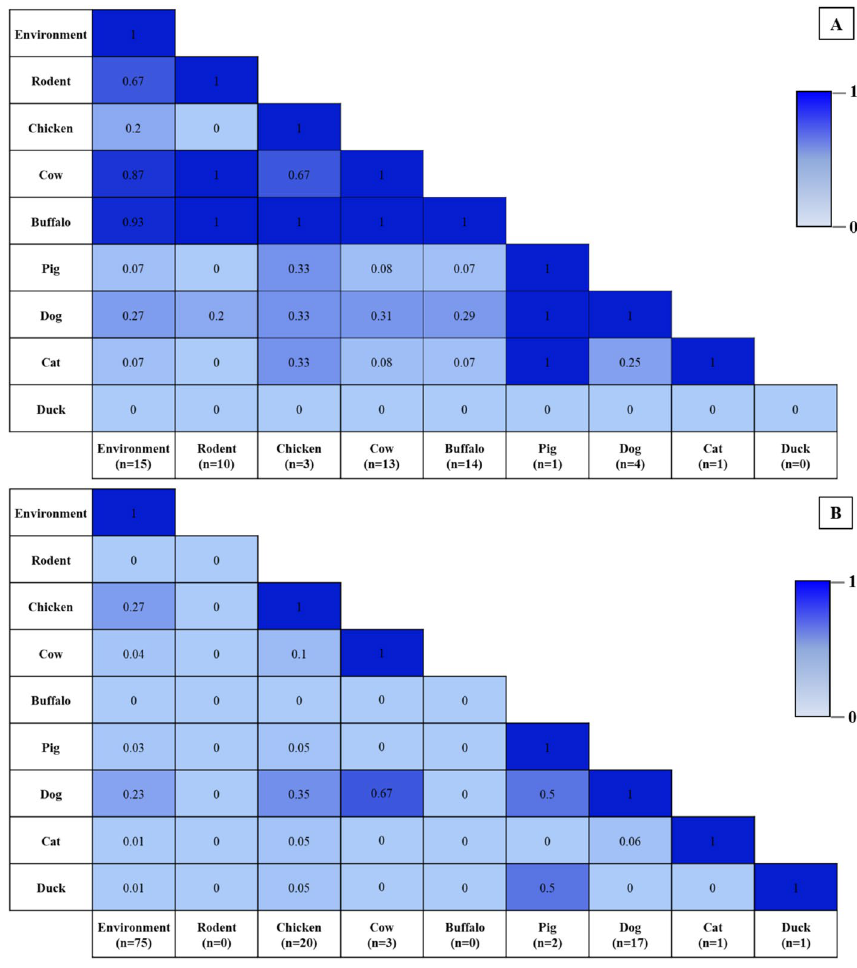
Figure 3. Coexistence between water sources and different animal species around water sources surveyed, ( A ) SSK and ( B ) NST. The values in the cells show the proportion of water sources with different animal